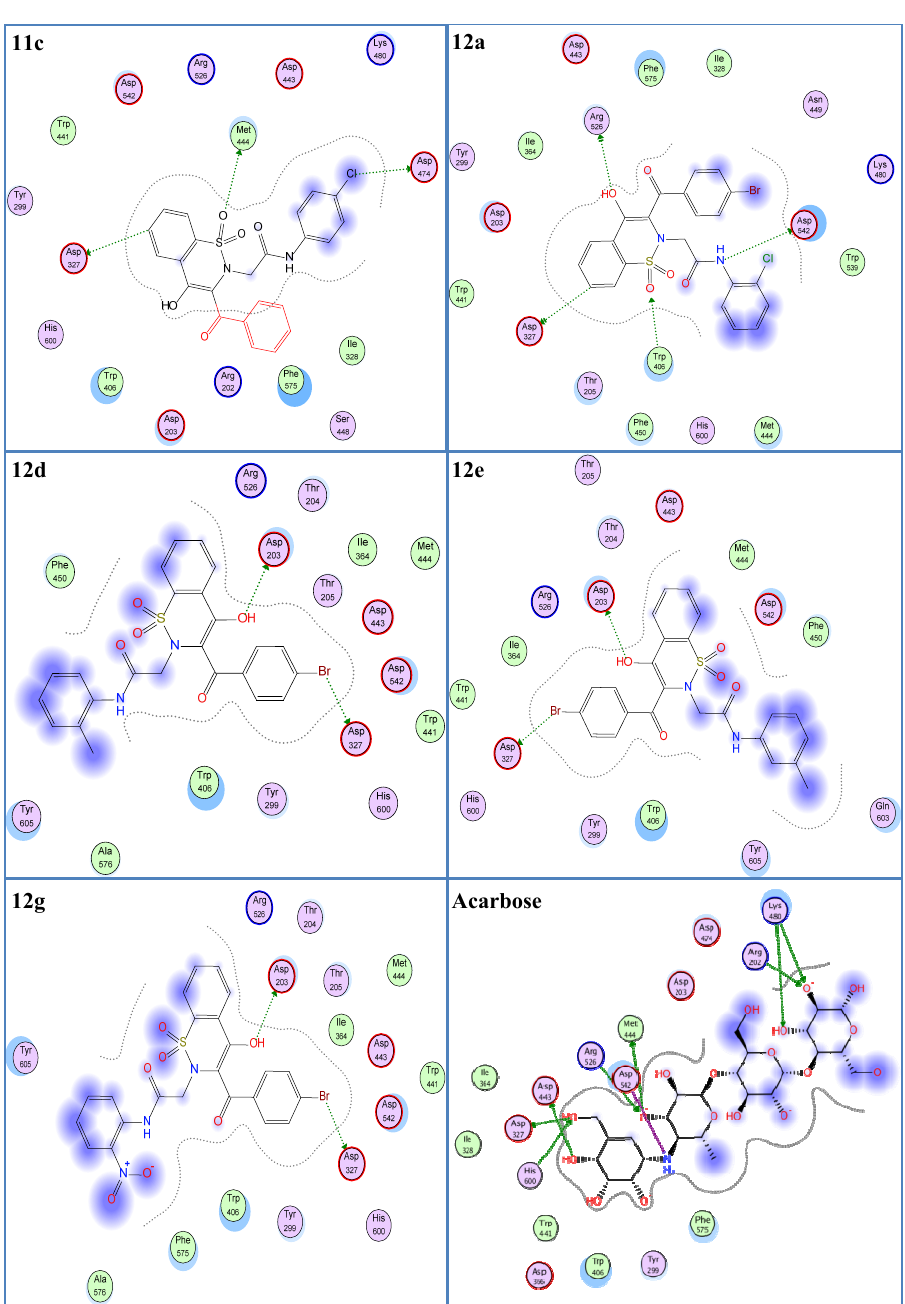
Figure 2. Two-dimensional interaction modes of the most active compounds ( 11c , 12a , 12d , 12e , 12g ) and the standard drug, acarbose. Blue color indicates ligand exposure and a green color dotted line indicates the interactions of receptor enzymes with ligands.